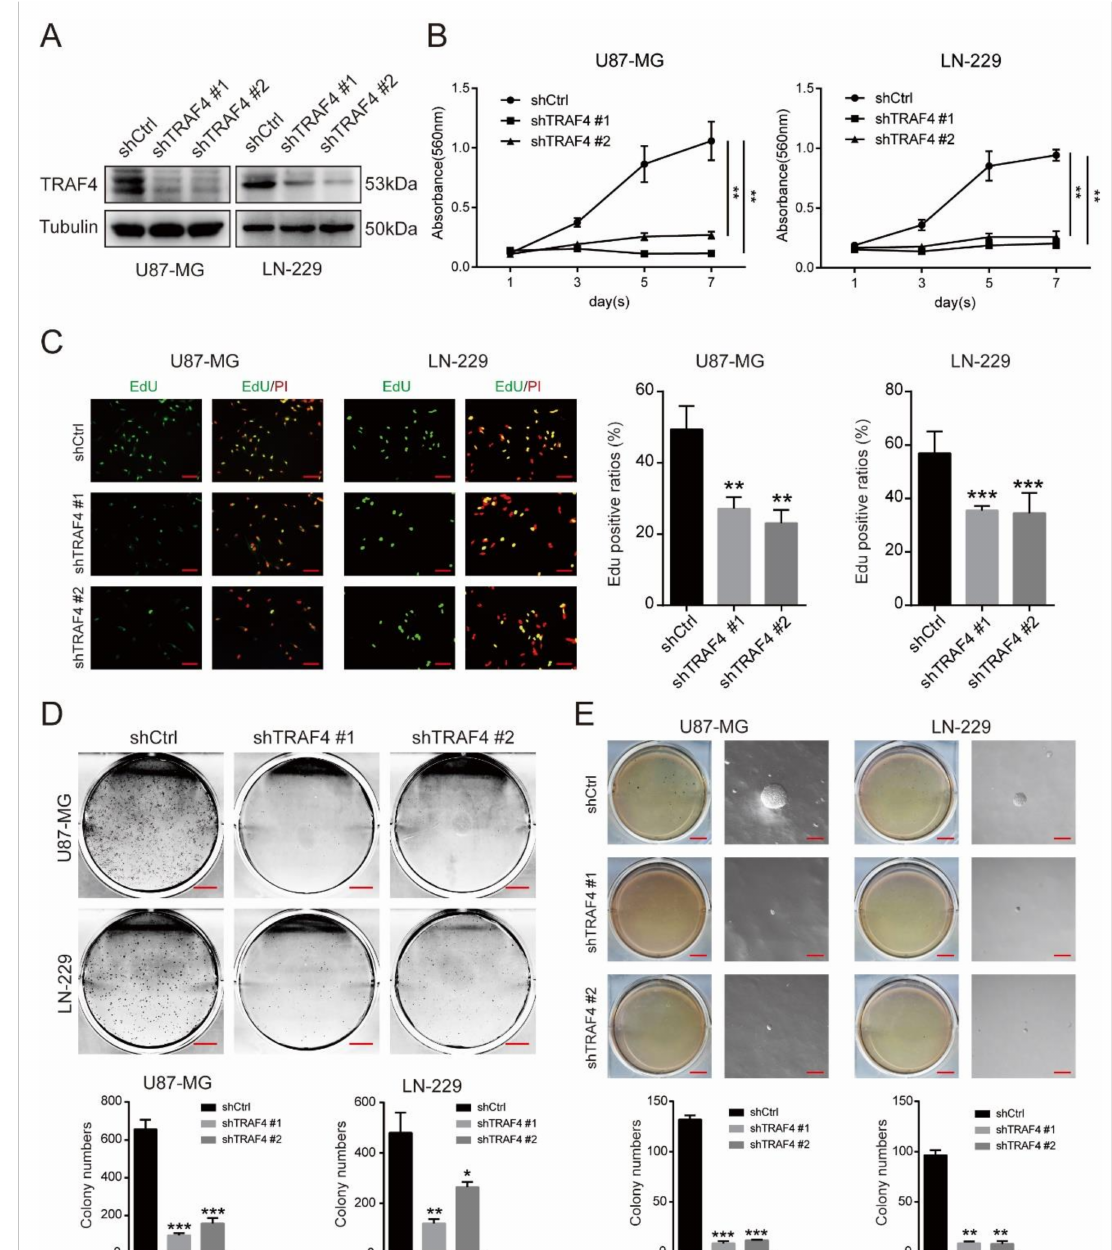
Figure 2. Downregulation of TRAF4 in glioblastoma cells inhibits cell proliferation. ( A ) TRAF4 expression was detected by Western blotting in glioblastoma cells following TRAF4 knockdown. ( B , C ) The viability and proliferation of glioblastoma cells detected by MTT assay and EdU